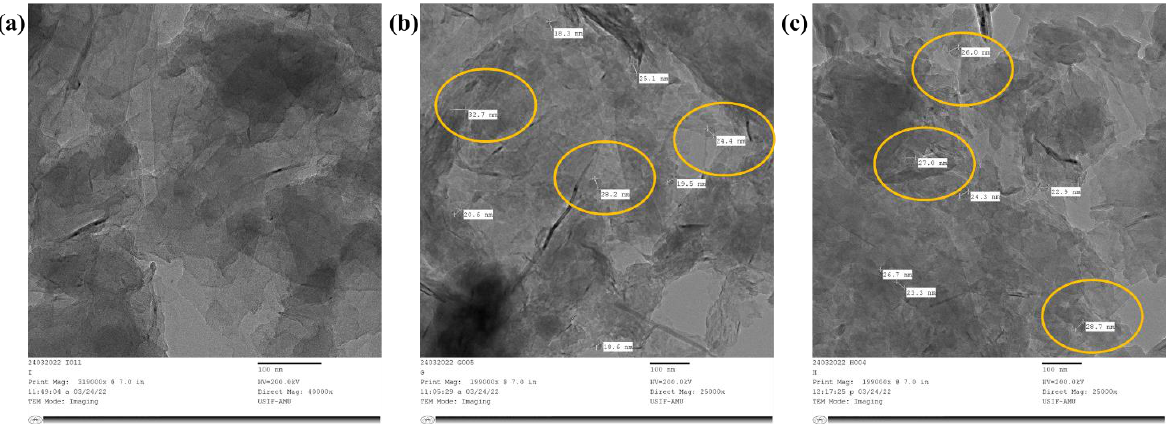
Figure 6. TEM images of ( a ) GO ( b ) GO-NCD- 1 and ( c ) GO-NCD- 2.